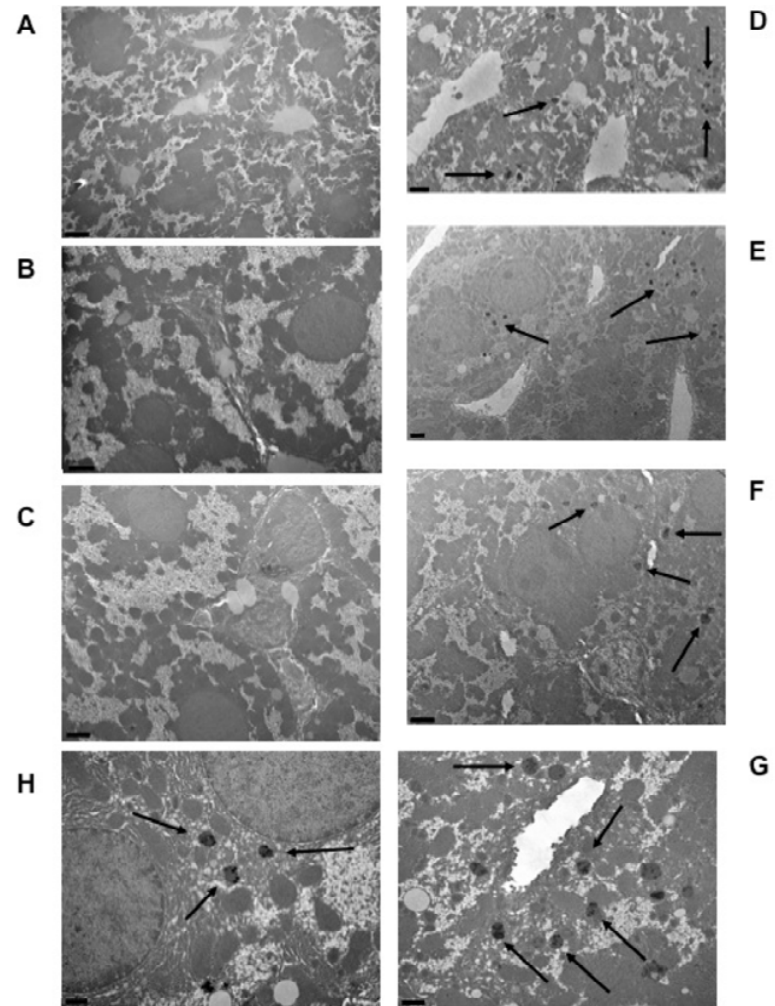
Figure 2. Metal deposits in liver cells of wild-type mice after 7 months of exposure to an aimara-containing diet. Transmission electron microscopy was performed on the liver from control mice (A–C) and aimara-fed mice (D–H). Scale bars appear in the left bottom corners of photos and represent 5 µm (A), 2 µm (B–F) and 1 µm (G and H). Black arrows indicate the metal deposits.